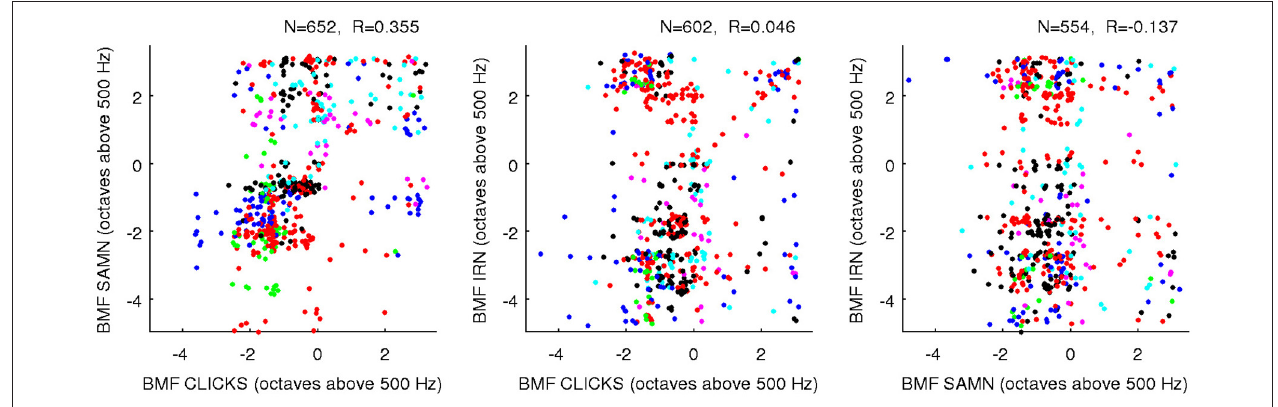
across animals; a random Gaussian distributed jitter with a standard deviation of 0.09 octaves has been added to the rBMF values to spread out overlapping data points. The number of multiunits in each data set ( N ) and correlation coefficient ( R ) are again shown above each